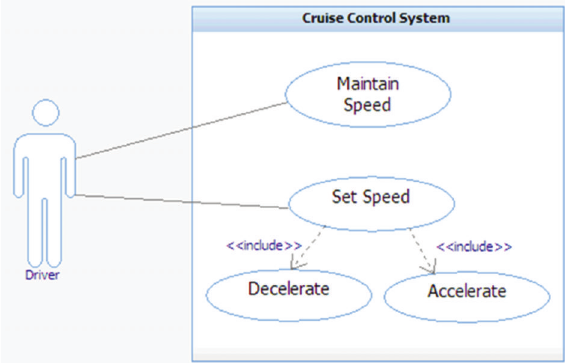
Figure 24: Use case